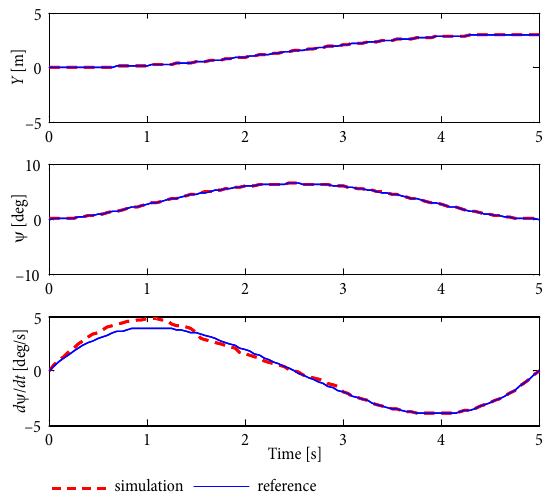
Fig. 9. Tracking trajectory comparison (lane-change case)